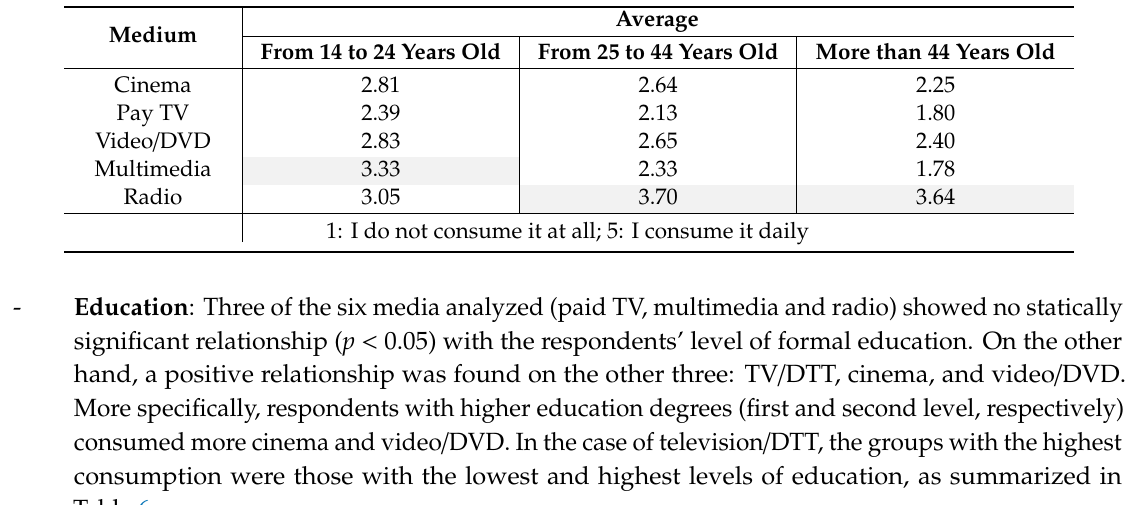
Table 5. Choice of audio-visual media outlet according to age (averages).